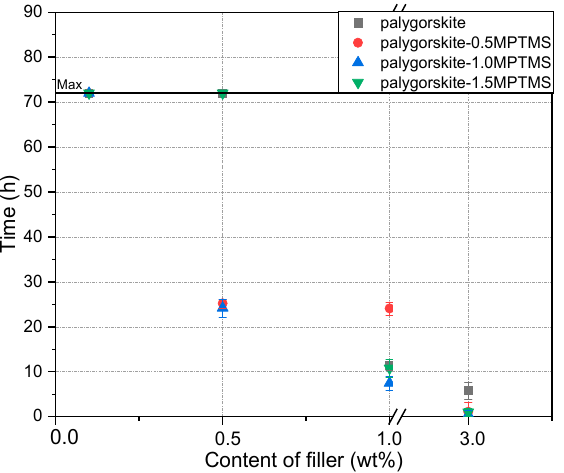
Figure 11. Influence of palygorskite modified by MPTMS addition on Si-PSA tape cohesion in 70 ◦ C.